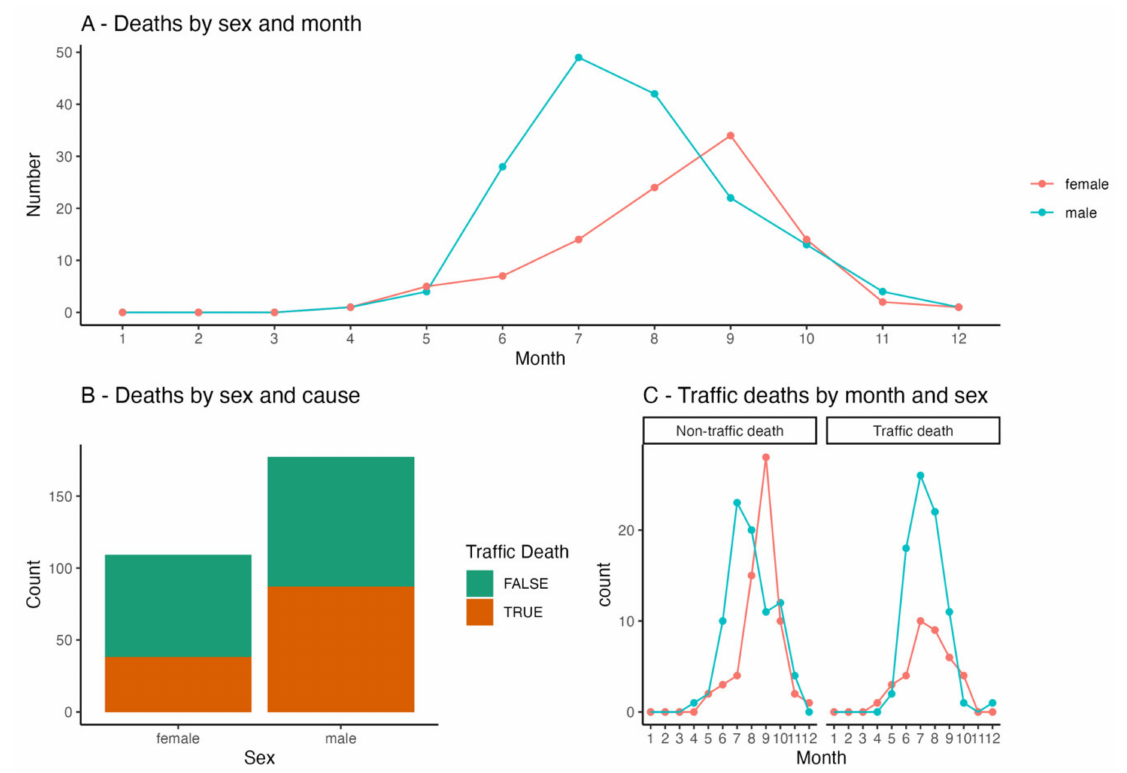
Figure 3. Proportion of deaths across the months of the year, disaggregated by sex ( A ): red colour represents females and blue colour represents males. Cause of death disaggregated by sex ( B ): orange colour is for traffic deaths and green colour is for non-traffic deaths (in-care, dying of other causes in the wild). Deaths disaggregated by both month and sex ( C ): red colour represents females and blue colour represents males.